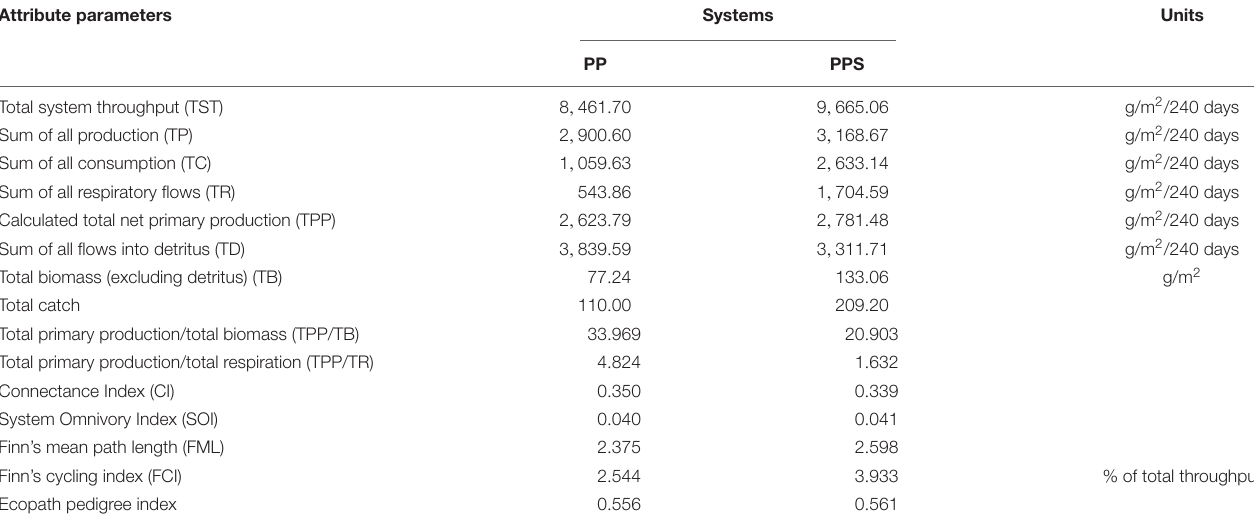
TABLE 4 | Comparison of energy flow parameters and characteristic parameters of the two integrated pond aquaculture